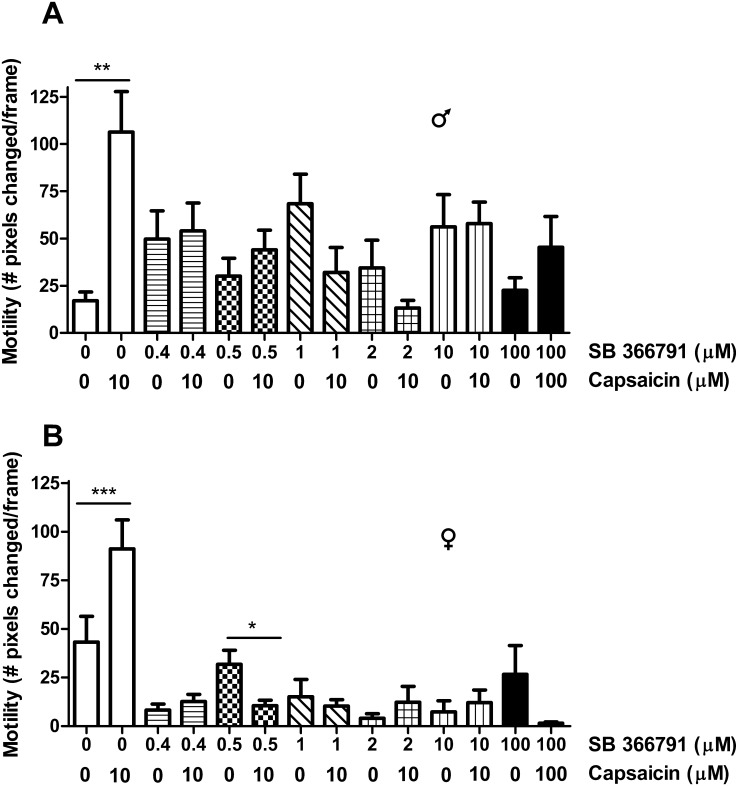
SB 366791, a potent, highly-selective TRPV1 antagonist, inhibits capsaicin-induced increased motility in S. mansoni adults.Motility was measured as in Fig 1 in individual males (A) and females (B). White bars show the significant increase in worm motility in response to 10 μM capsaicin in the absence of SB 366791. Differently patterned bars designate worm motility in 0 vs. 10 μM capsaicin following pre-incubation in (and co-exposure to) SB 366791 at concentrations of 0.4 μM (horizontal lines), 0.5 μM (checkerboard), 1 μM (diagonal lines), 2 μM (squares) or 10 μM (vertical lines). The pair of black bars shows responses of worms to 100 μM capsaicin in the presence of 100 μM SB 366791 (see Methods for details). There is a significant increase in worm motility in response to capsaicin only in the absence of SB 366791. *, **, ***, P<0.05, P<0.01, P<0.001 respectively, paired t-tests vs. no-capsaicin controls. n = 4–8.